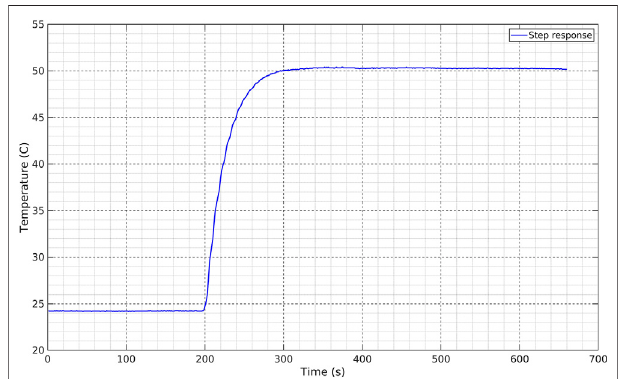
FIGURE 2 | time response of Pt1000 temperature probe obtained by suddenly immersing the probe in hot water.